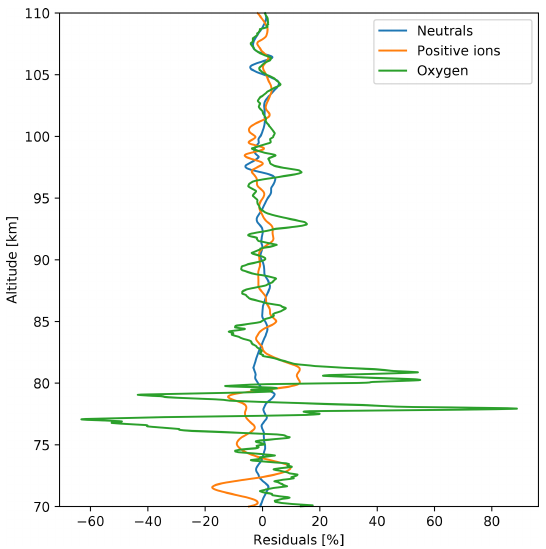
Figure 11. Relative density fluctuations (residuals) of neutral air, positive ions, and atomic oxygen shown by blue, orange, and green profiles, respectively. These fluctuations were derived from the den- sity profiles measured on the downleg of the WADIS-2 rocket flight by subtracting a running average over a 5km long vertical